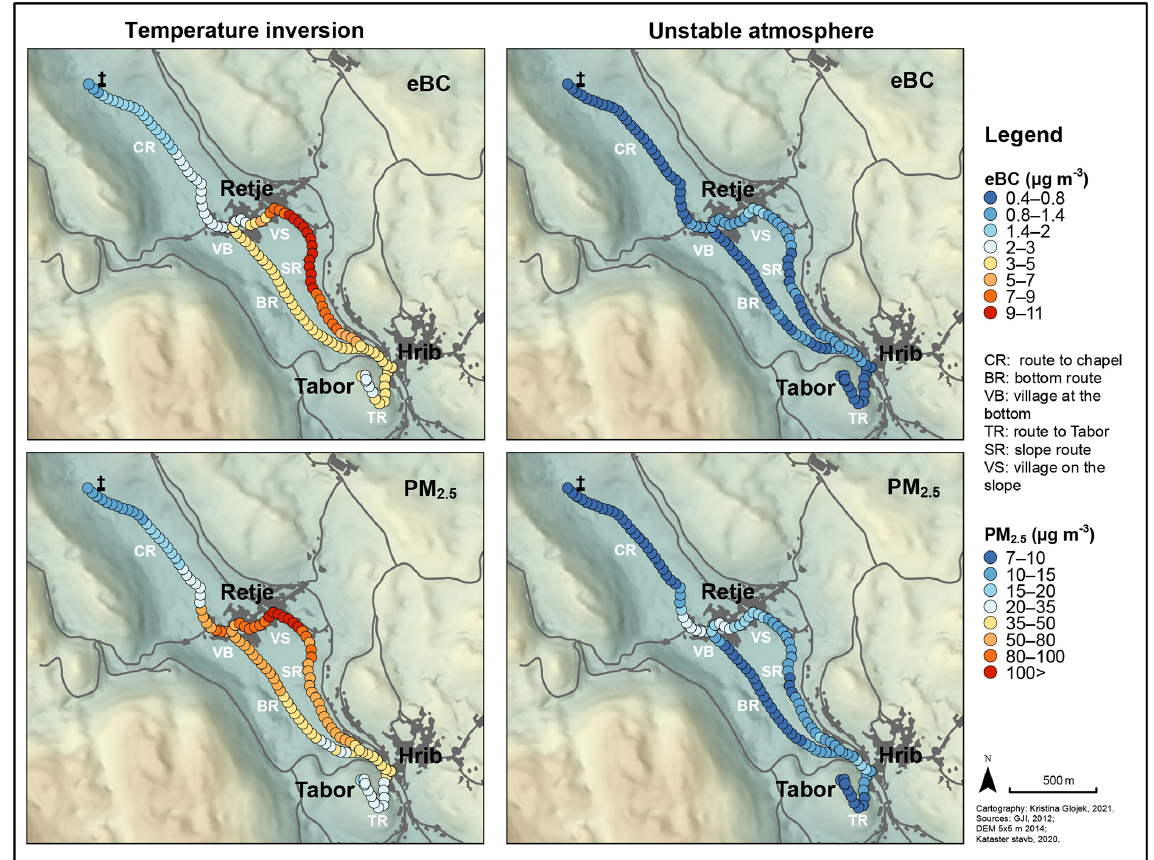
Figure 3. Spatial distribution of eBC (upper part) and PM 2 . 5 (lower part) mass concentrations during temperature inversions (left-hand side) and during unstable atmosphere (right-hand side) along Retje karst hollow. The spatial average of pollutant levels or all selected runs is